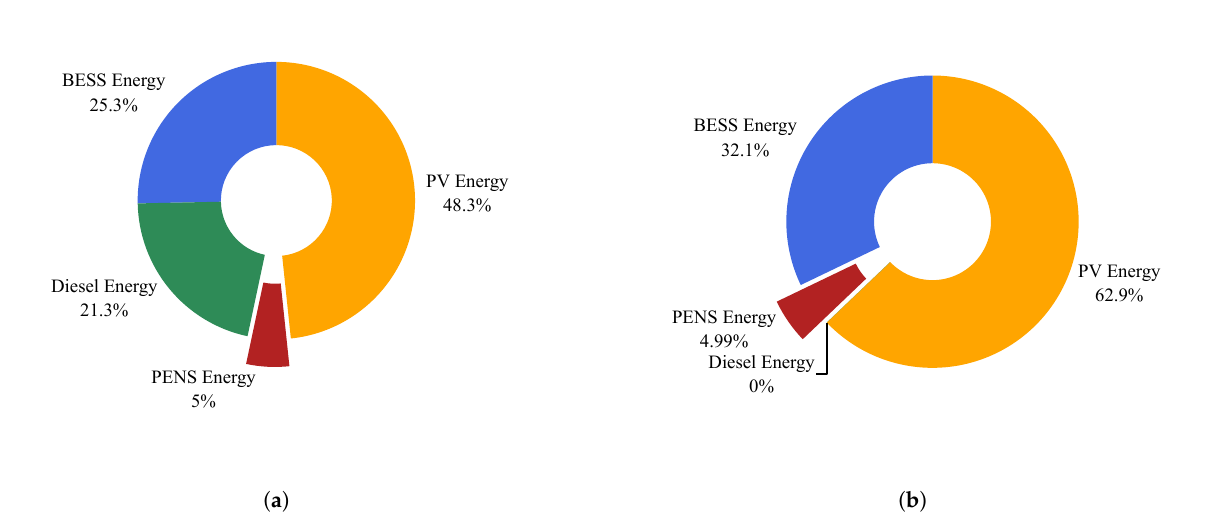
Figure 12. Energysuppliedtotheloadinayear. ( a )PV-BESS-DGconfiguration; ( b )PV-BESSconfiguration. Figure 13 corresponds to the energy supplied to the load in a day from